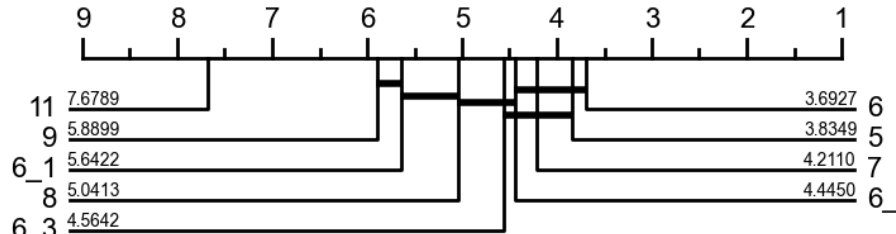
Figure 9. Mean rank of CEEMD-MultiRocket using different convolution kernel lengths.